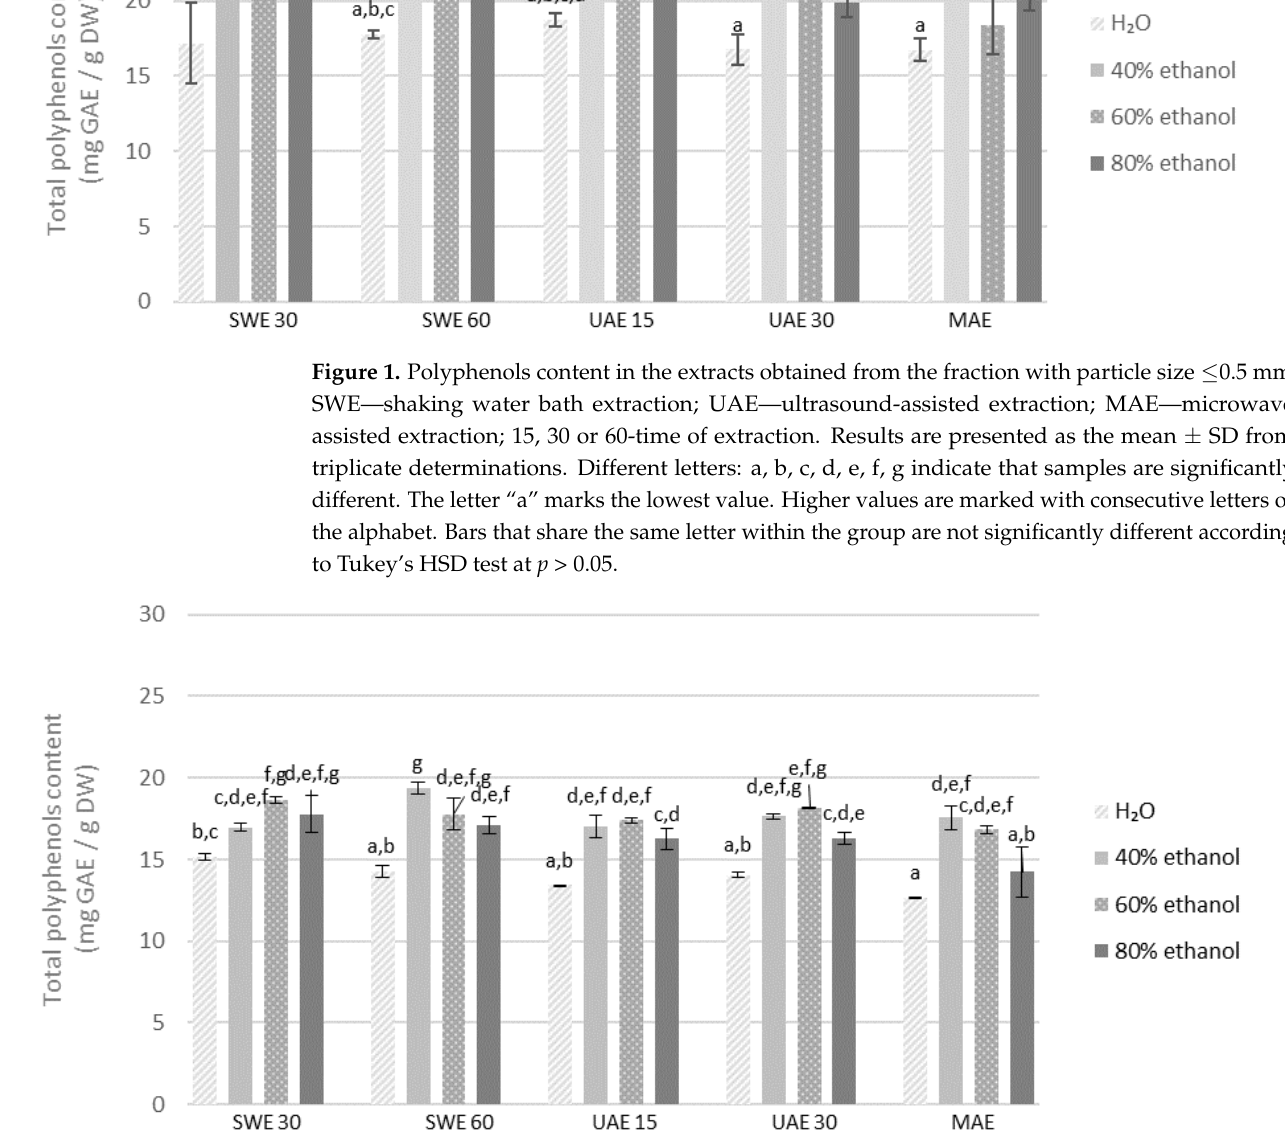
Figure 2. Polyphenols content in the extracts obtained from the fraction with particle size 0.5–1.25 mm. SWE—shaking water bath extraction; UAE—ultrasound-assisted extraction; MAE—microwave assisted extraction; 15, 30 or 60-time of extraction. Results are presented as the mean ± SD from triplicate determinations. Different letters: a, b, c, d, e, f, g indicate that samples are significantly different. The letter “a” marks the lowest value. Higher values are marked with consecutive letters of the alphabet. Bars that share the same letter within the group are not significantly different according to Tukey’s HSD test at p >